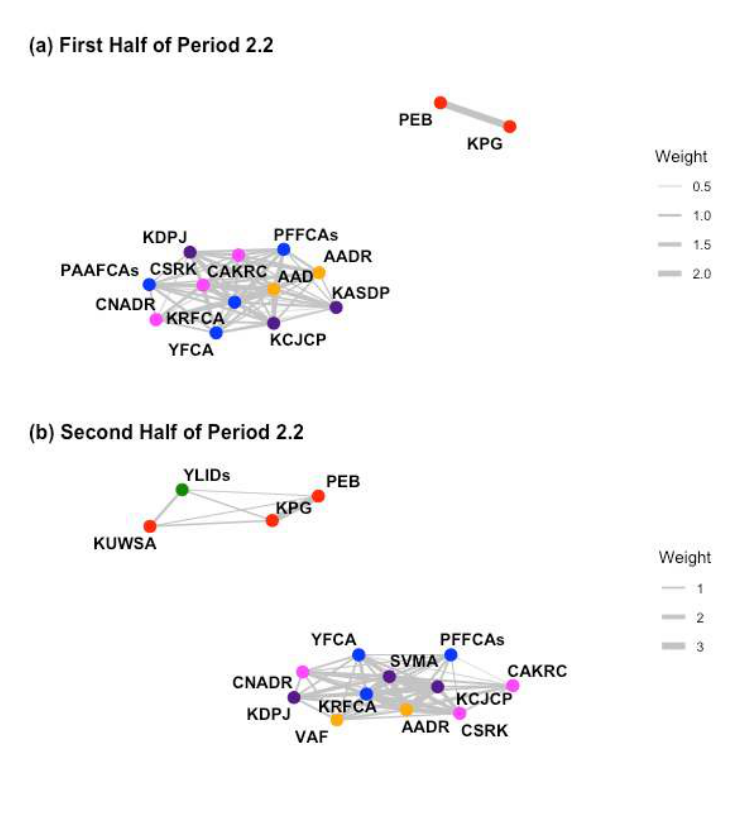
Figure 2. Changes in actors’ congruence networks (Period